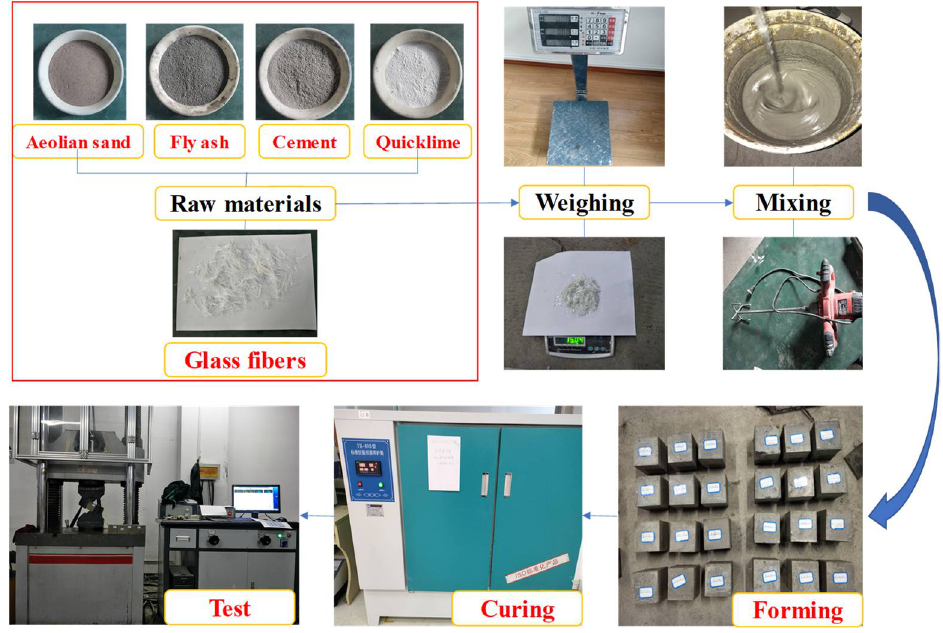
Figure 7. Manufacturing process of the shotcrete specimens.